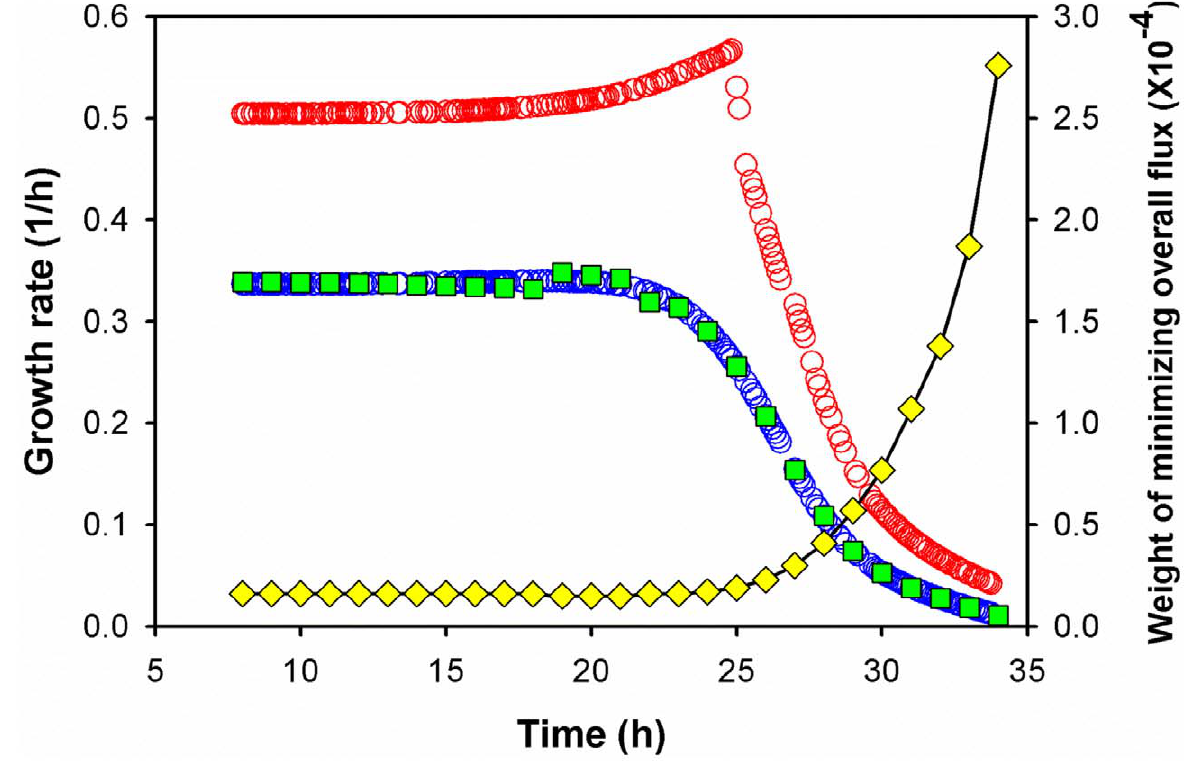
Figure 3. Prediction of growth rates (h 2 1 ). Blue # : growth rate determined by the Monod model. Red # : dFBA prediction using the objective function (maximization of growth rate). Green % : dFBA prediction using dual-objective functions (maximization of growth rate and minimization of overall flux). Yellow e : the weight of the dual-objective functions that predicted the measured growth rates. Note: the summation of the square of fluxes ( g v 2 ) was a very large number (total 774 fluxes), so the magnitude of weight w was small.